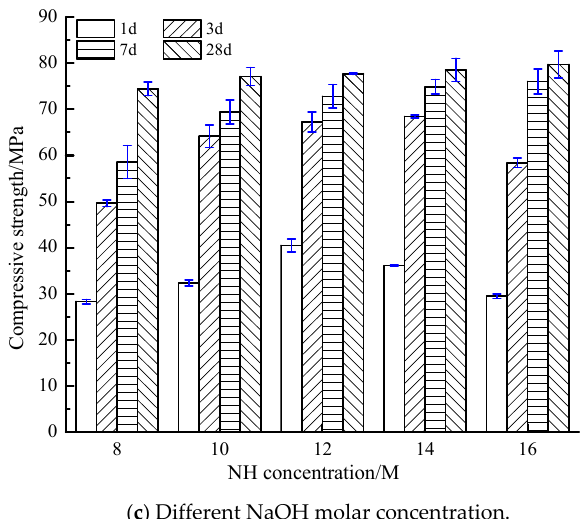
Figure 2. Compressive strength of AACGS samples.( a ) Different slag content; ( b ) Different liquid–solid ratio; ( c ) Different NaOH molar concentration.